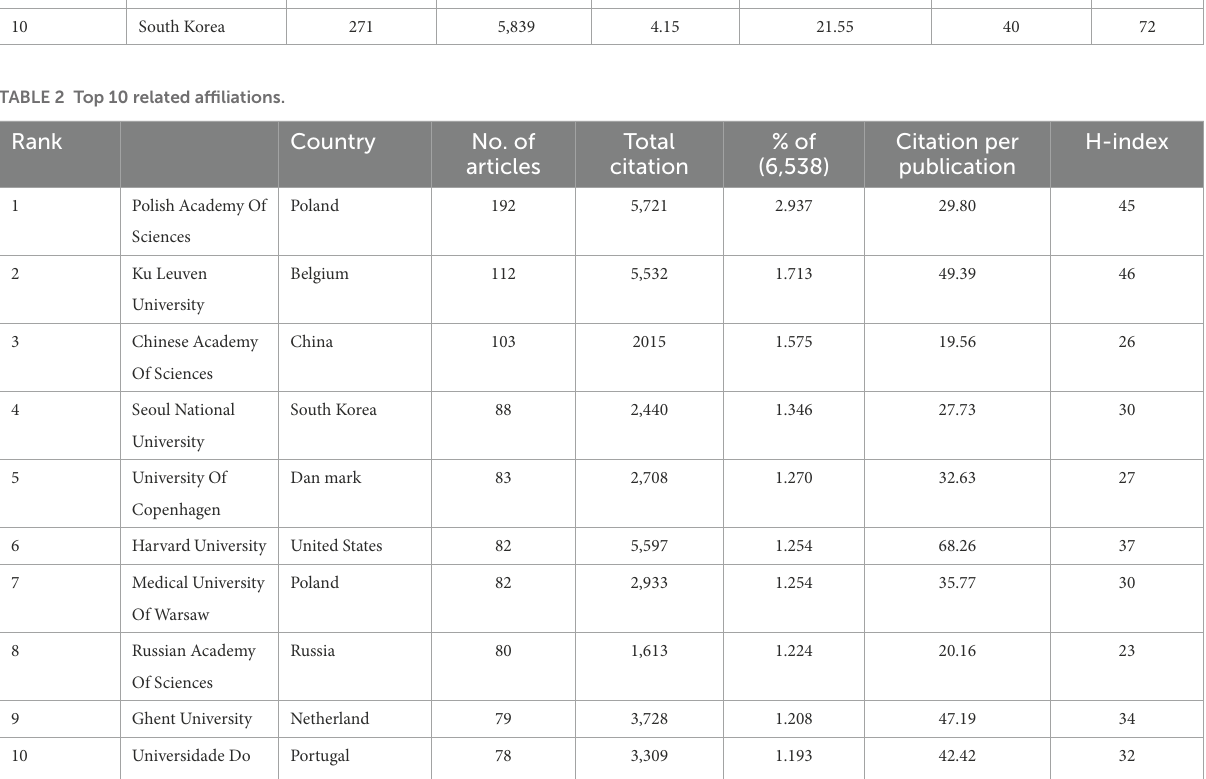
TABLE 2 Top 10 related affiliations.